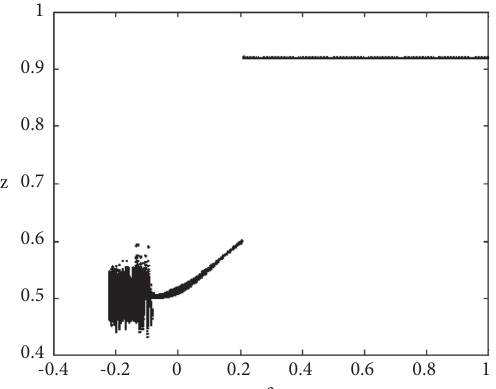
Figure 4: Dynamic behaviors of the chaotic third-order power system with a